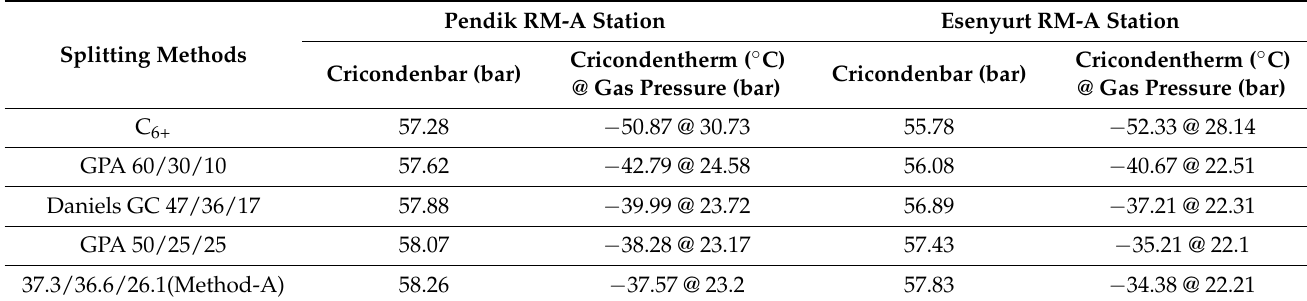
Table 6. Comparison of the splitting methods for process analysis.